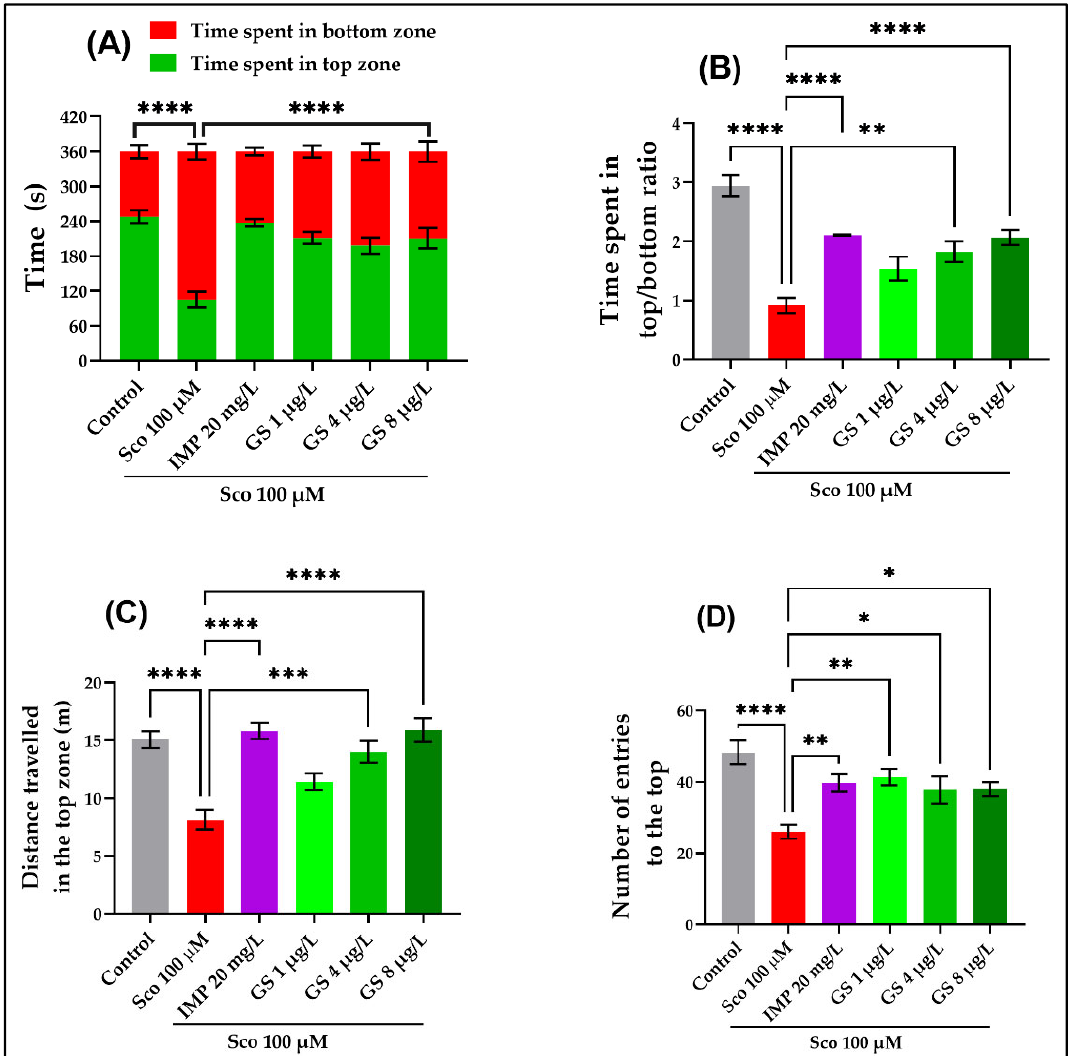
Figure 2. NTT results for Guiera senegalensis hydroethanolic extract (GS: 1 μ g/L, 4 μ g/L and 8 μ g/L). ( A ) Time spent in the top/bottom zone. ( B ) Time spent in top/bottom ratio. ( C ) Total distance travelled in the top zone. ( D ) Number of entries to the top zone. Data are expressed as mean ± S.E.M. (n = 10). For Tukey’s post hoc analyses: * p < 0.01, ** p < 0.001, *** p < 0.0001 and **** p < 0.00001.